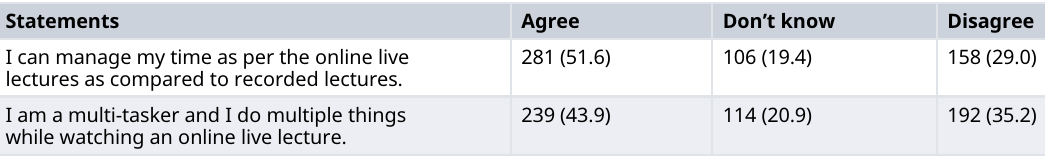
Table 2. Quantitative findings on students ’ perception towards live